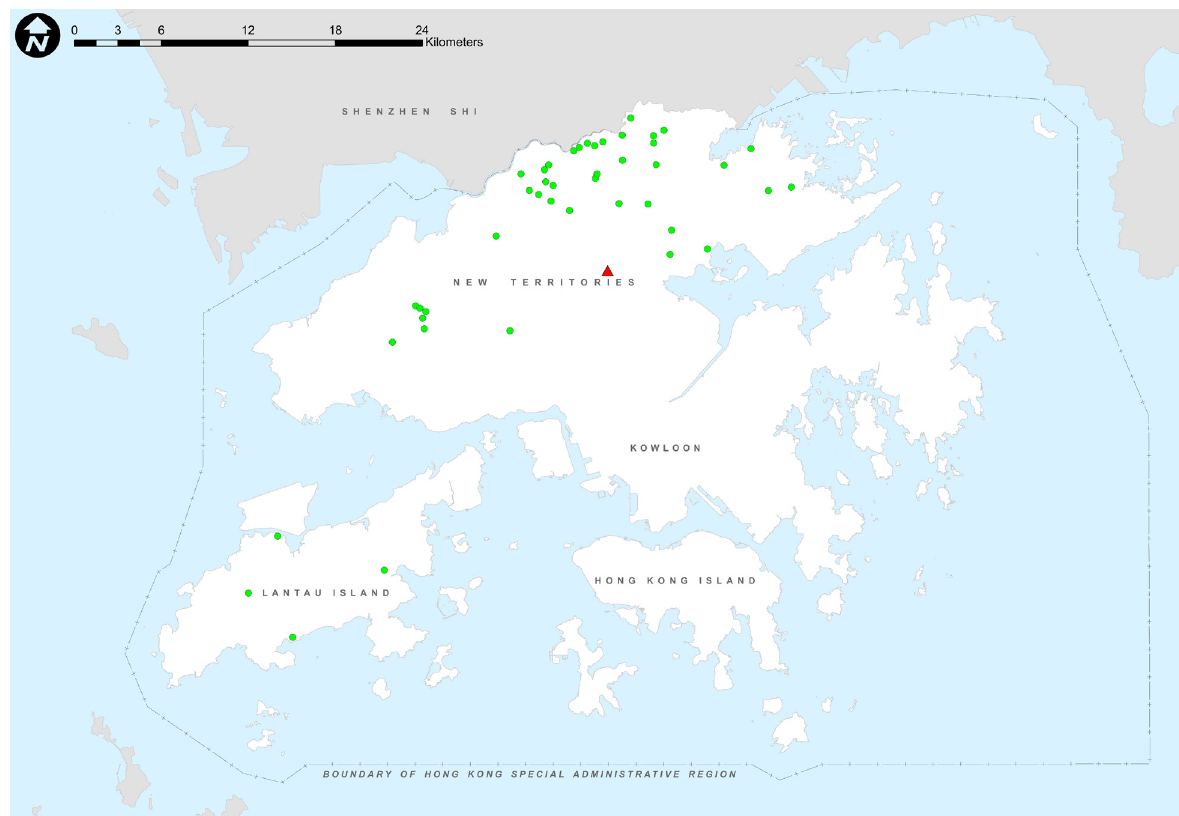
Figure 1. Study Area of Hong Kong Special Administrative Region, People’s Republic of China and the distributional range of Somanniathelphusa zanklon . Green Circles indicate locations of S. zanklon as part of this review; red triangle indicate type locality